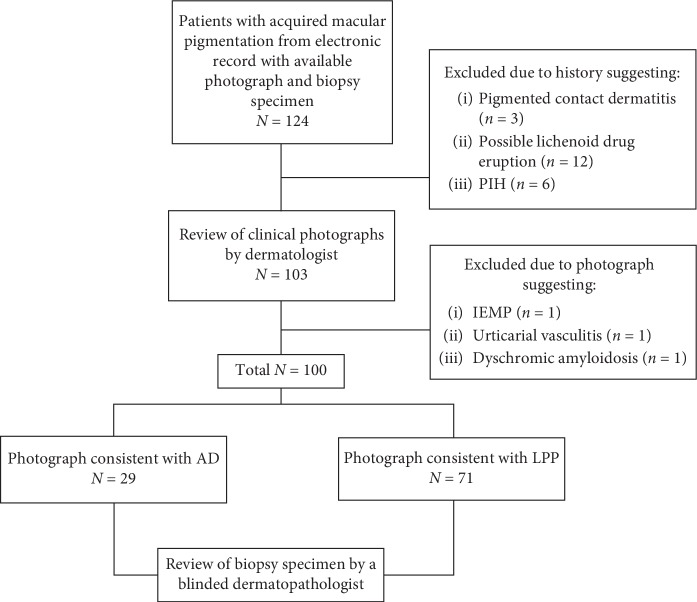
Protocol flowchart. AD, ashy dermatosis; IEMP, idiopathic eruptive macular pigmentation; LPP, lichen planus pigmentosus; PIH, postinflammatory hyperpigmentation.